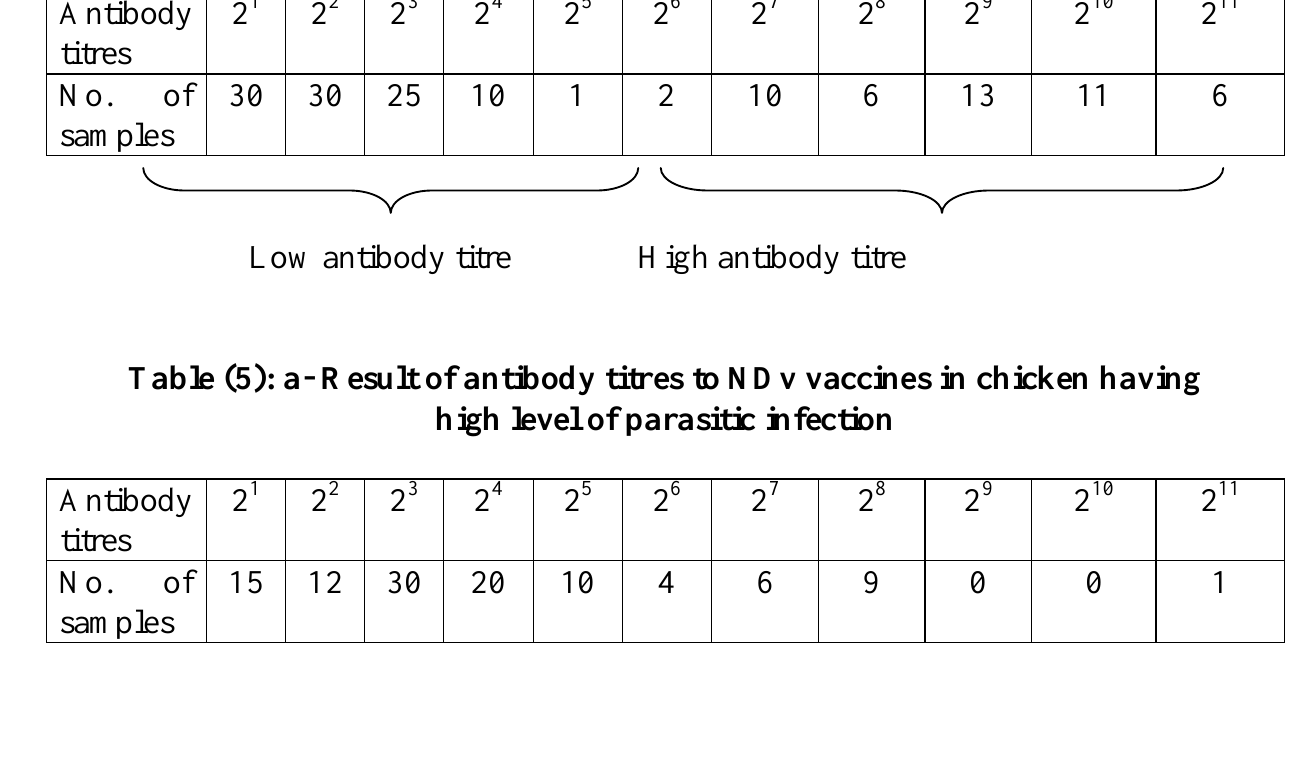
Table (5): b- Result of antibody titres to NDv vaccines in chickens having